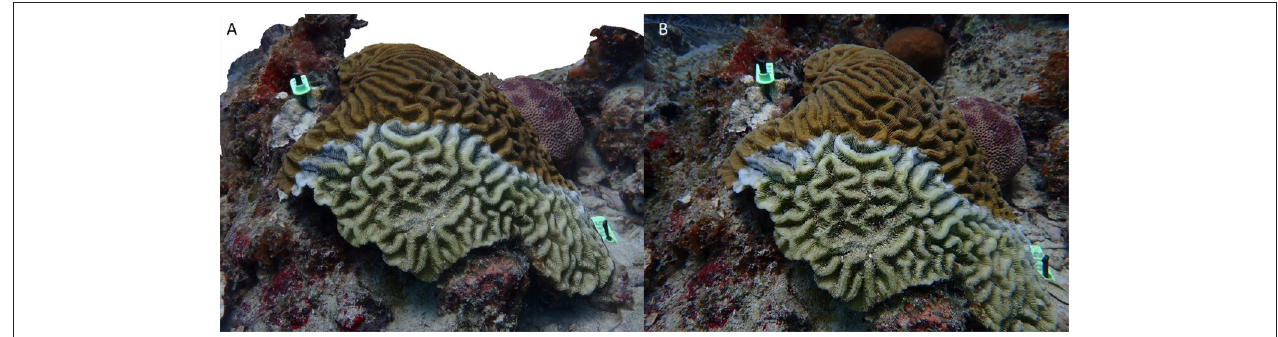
FIGURE 2 | Comparison of 3D model and photograph. (A) Screenshot of a 3D model of a C. natans affected with SCTLD. (B) One of the photographs used to build the model seen in (A) .